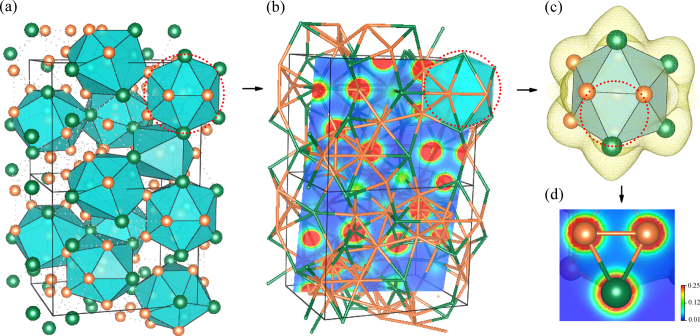
General view of the interpretation for the CPGAMEC rule, based on the charge distribution of Gauss’s law and the cluster structural features of CMAs: (a) Atomic clusters existed in the structure of Zr3Cu8 ICs, (b) Charge density distribution of Zr3Cu8 ICs, (c) Charge density of the CN12 Cu8Zr5 icosahedral cluster presented in the structure of Zr3Cu8 ICs (the isosurface is 0.02 e/Bohr3), (d) Color-contour maps on the Cu-Zr-Cu triangle plane of CN12 Cu8Zr5 cluster in Zr3Cu8 ICs.